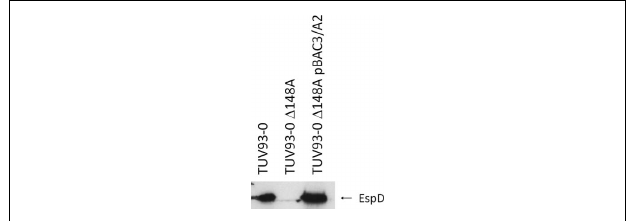
FIGURE 1 | Complementation ofT3S inTUV93-0 (cid:2) 148A. The LEE containing clone pBAC3/A2 was introduced into theTUV93-0 (cid:2) 148A containing a partial deletion of the LEE. A western blot of secreted proteins isolated fromTUV93-0 (wt),TUV93-0 (cid:2) 148A, and the complemented strain TUV93-0 (cid:2) 148A pBAC3/A2 are